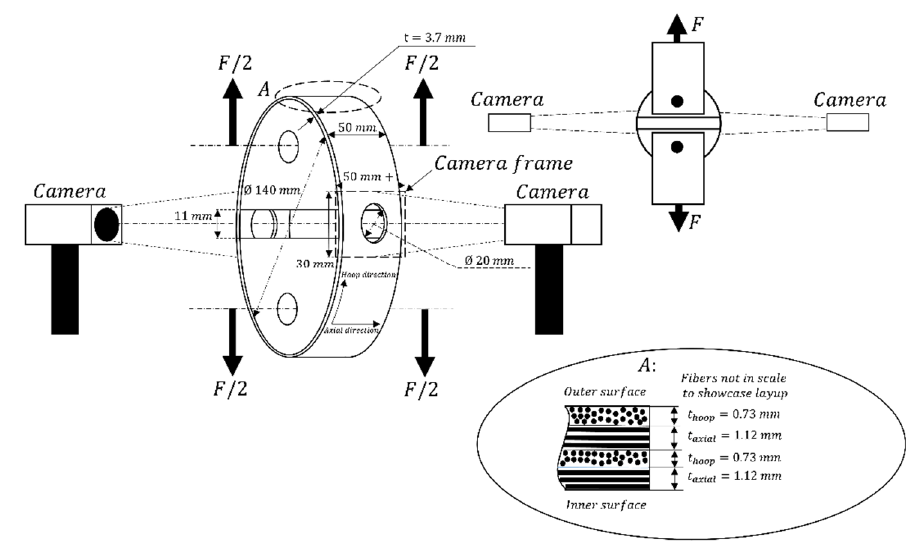
Figure 1. Experimental setup with geometry of test sample and layup; fibers not to scale.